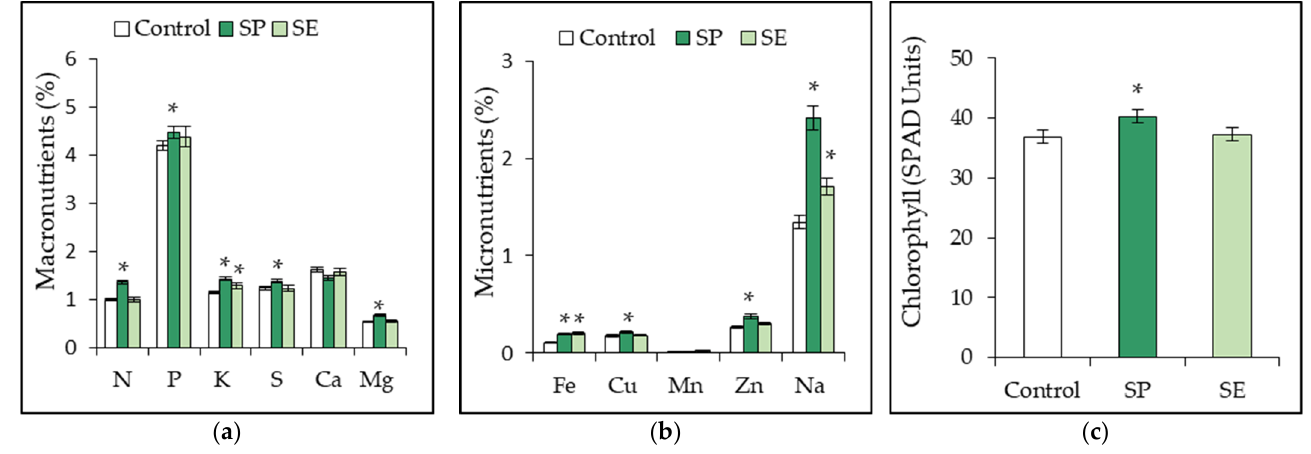
Figure 4. Mineral composition: ( a ) macronutrients, ( b ) micronutrients (% dry weight), and ( c ) chlorophyll content (soil and plant analysis development [SPAD] units) in the leaves of 45-day-old tomato plants treated with seaweed powder (SP) or seaweed extract (SE) from Ulva ohnoi . Values represent mean ± standard deviation (n = 12 for chlorophyll and n = 3 (mix of 4 plants each one) for macro- and micronutrients). Asterisks (*) over the bars indicate significant differences of each treatment in comparison to the control (untreated plants), based on the Holm–Sidak means comparison test ( p < 0.05).